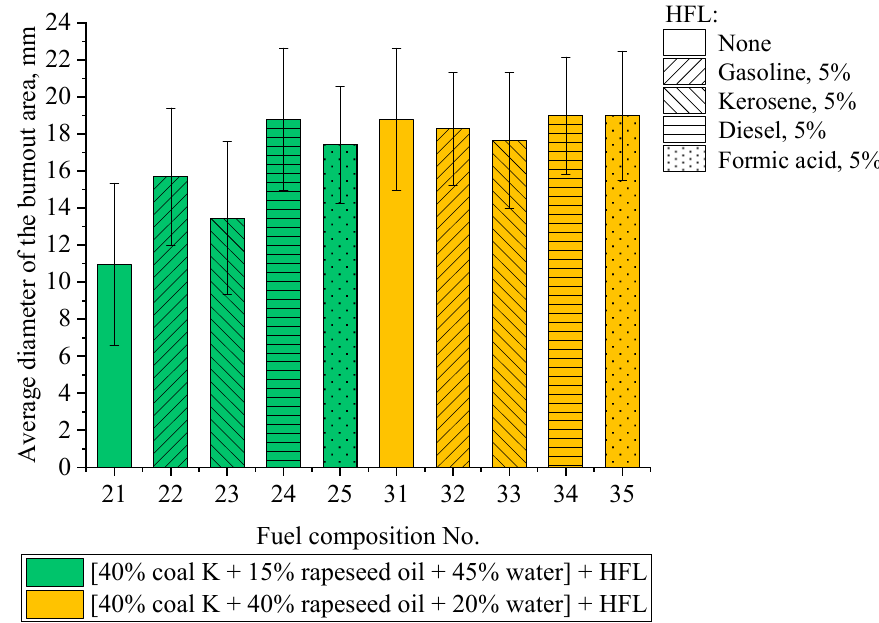
Figure 10. Average sizes of region where components of composite fuels with different HFL additives burn out.